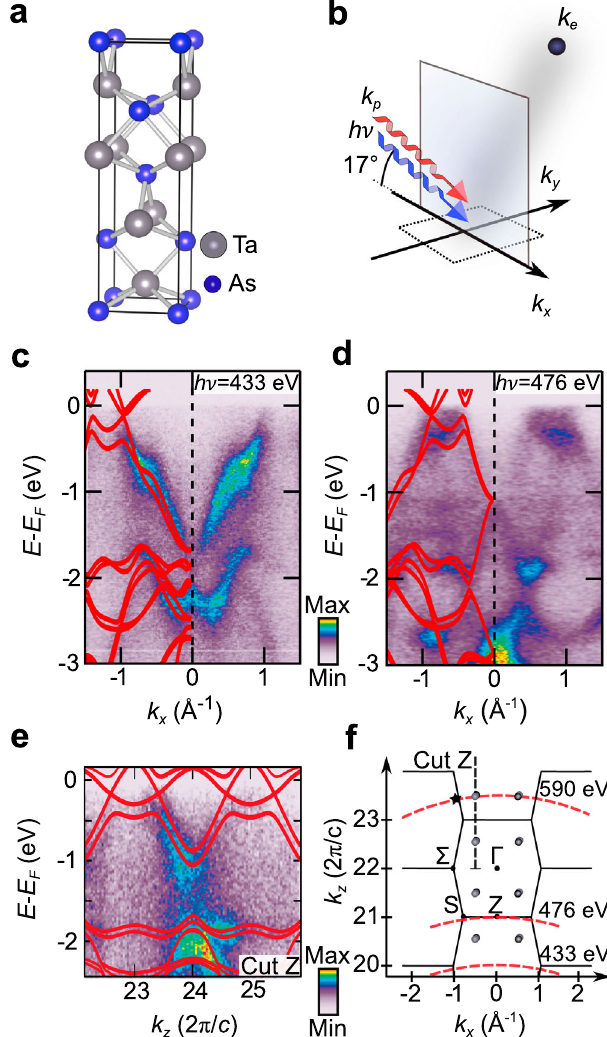
Fig. 1 Bulk electronic structure of TaAs. a Bulk crystal structure of TaAs with space group I 4 1 md . b Experimental geometry of the angle-resolved photoemission spectroscopy (ARPES) experiment using circularly polarized soft X-ray radiation. c , d ARPES data sets along the ΓΣ and ZS high-symmetry directions of the bulk Brillouin zone. e ARPES data set along k z at k x = − 0.53 Å − 1 , corresponding to the calculated k x position of the W 2 Weyl nodes (cut Z in f ). In c – e , the red lines represent the calculated band dispersion. f Bulk Brillouin zone structure in the k x – k z plane. W 2 Weyl nodes at k z ¼ 23 : 41 2 π c are addressed at a photon energy of approximately h ν = 590eV (cf. Figs. 2 and 3). The star marks the (k x ,k z ) position of the data set in Fig.